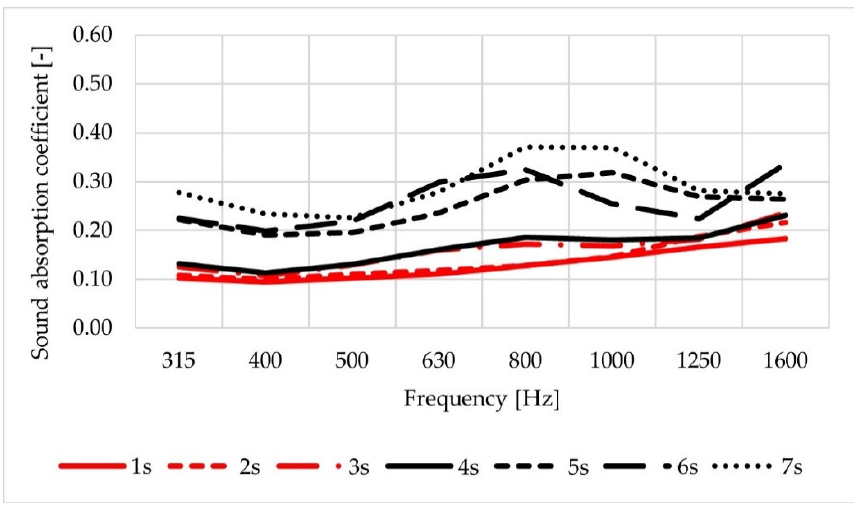
Figure 9. Average values of sound absorption coefficient obtained for the test slabs.